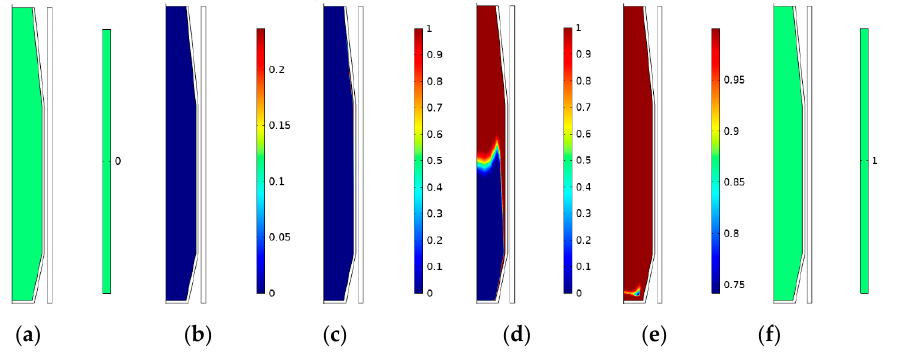
Figure 8. Phase change of the explosive. ( a ) 0 min. ( b ) 8 min. ( c ) 10 min. ( d ) 30 min. ( e ) 50 min. ( f ) 52 min.